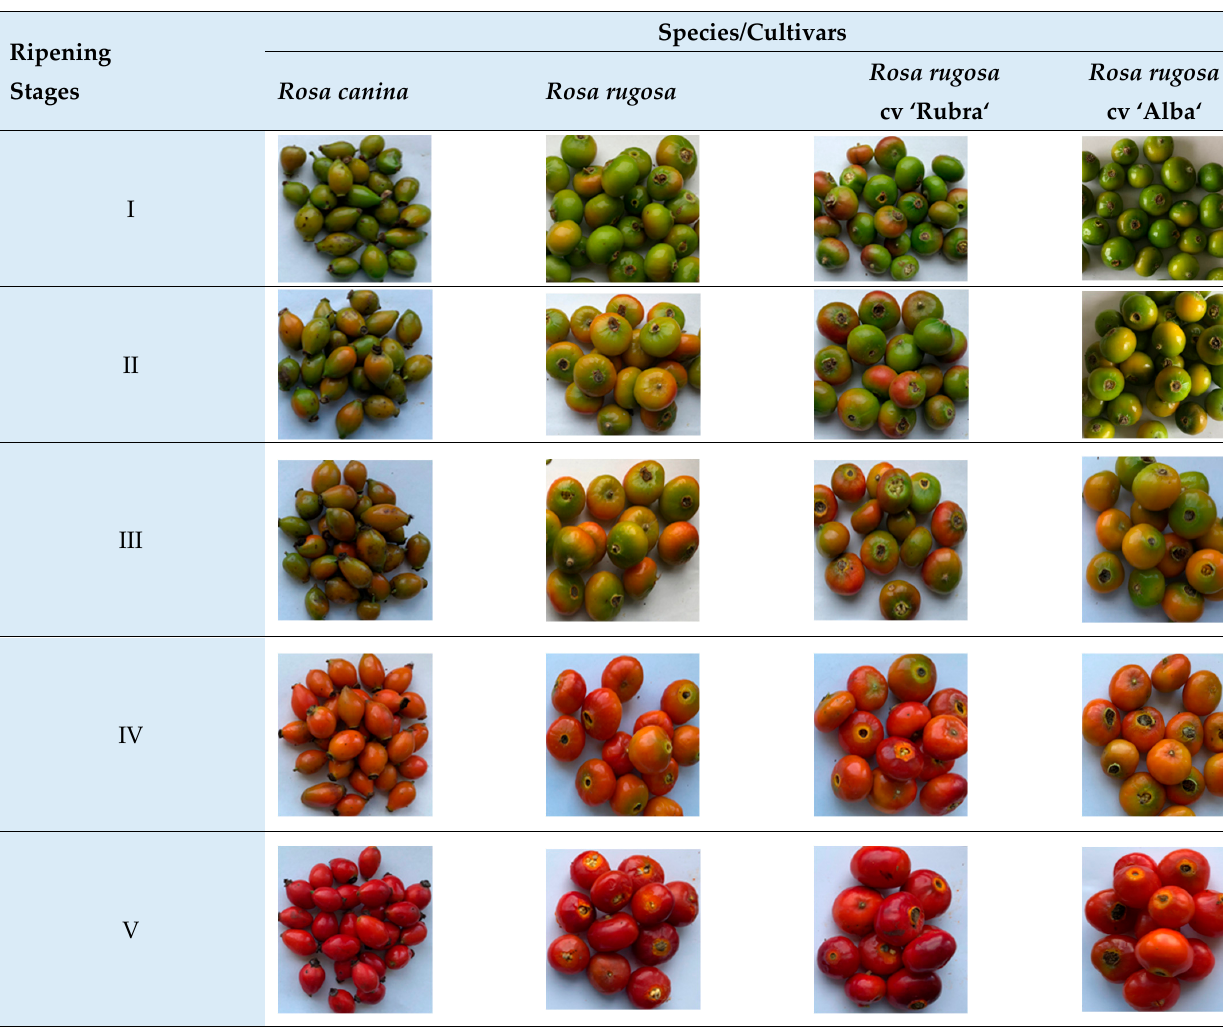
Figure 1. Fruit ripening stages of Rosa samples (photos by B. Medveckiene). The weather data during experimental period in 2018 and 2019 are shown in Table 1. Table 1. Weather data during experimental period in 2018 and 2019.